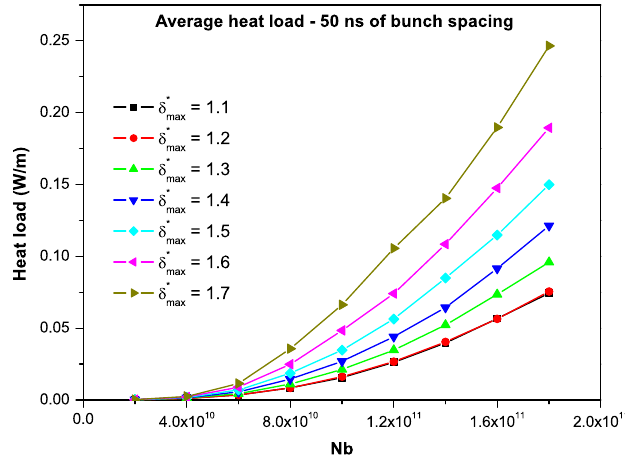
FIG. 10. Average heat load for the simulation set B.